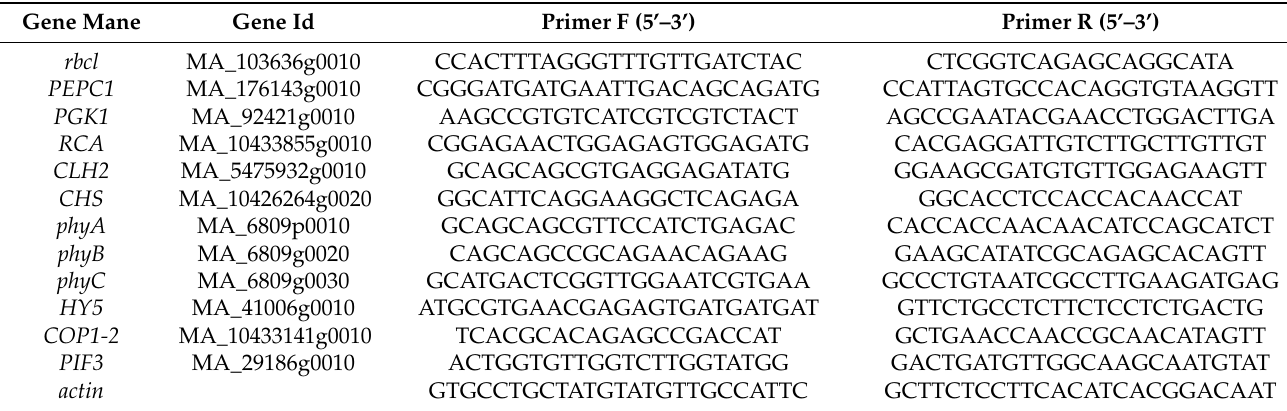
Table 1. The primer sequences of photosynthesis-related genes.